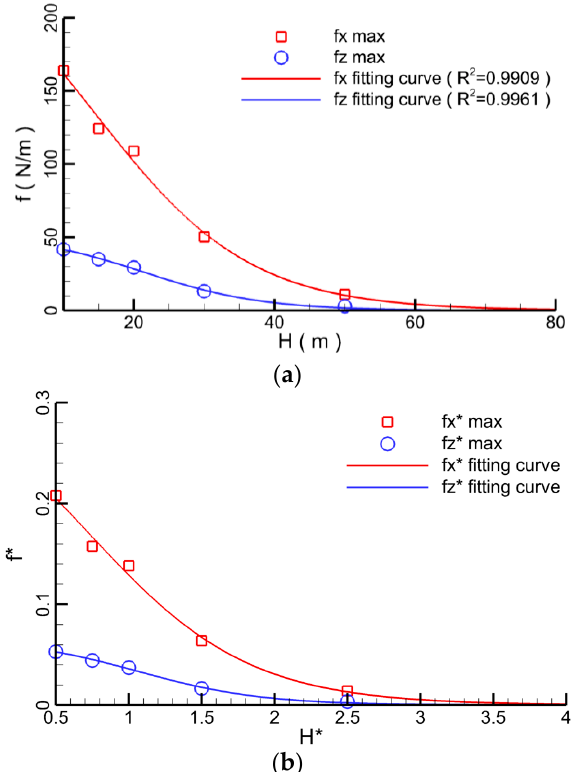
Figure 21. The hydrodynamic force on pipeline with different water depths. ( a ) Maximum force. ( b ) Non-dimensional maximum force.